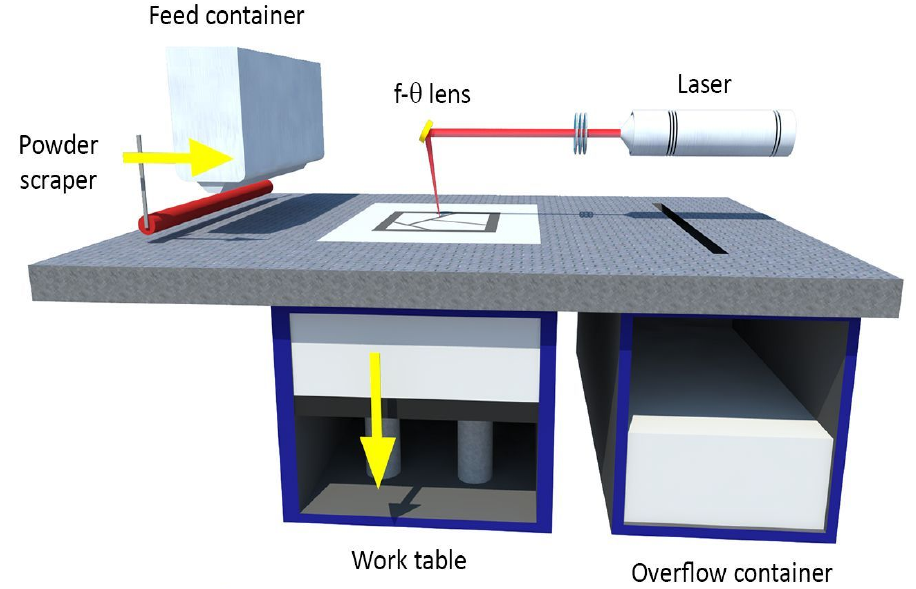
Figure 10. Scheme of selective laser sintering.